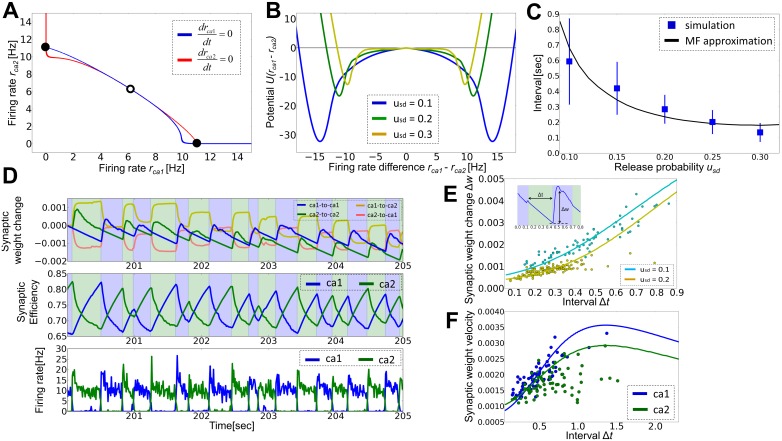
STD induces alternate excitations of assemblies, which enlarges synaptic weights within the assemblies.(A) Null-clines of firing rates for a synaptic weight matrix calculated from equation (9). (B) Potential function U is calculated for the difference in firing rate between two assemblies. The normalization factor U
0 is determined to ensure U(0) = 0. (C) A monotonic relationship between the release probability and the average interval of the alternation of cell assemblies. The interval was defined as a duration in which one assembly continuously shows higher firing rates than the other. Firing rates were calculated in 10 milliseconds-long time bins. Error bars are the standard derivation of intervals observed during 80 seconds after the stimulus termination in a simulation trial. (D), Typical behavior of the average synaptic weights (above), synaptic efficiency for STD (middle), and neuronal firing rates (below). The first (blue) and second (green) cell assemblies show high firing rates alternately. (E) Relationship between the interval and synaptic weight change for usd = 0.1 (cyan) and usd = 0.2 (yellow). Inset illustrates the two quantities shown. The ordinate shows synaptic weight change Δw in an interval (Δtw = 80 milliseconds) starting from the activation of the corresponding cell assembly. Dots are data points obtained from simulation, while solid curves indicate analytic results. (F) Interval dependence of the synaptic weight velocity is shown, which was defined as an expected synaptic weight change in a second. Solid curves show the analytic results calculated at Jca1 = 0.311, Jca2 = 0.287, Jbg = 0.156, rca1 = 13.38 Hz and rca2 = 12.82 Hz.